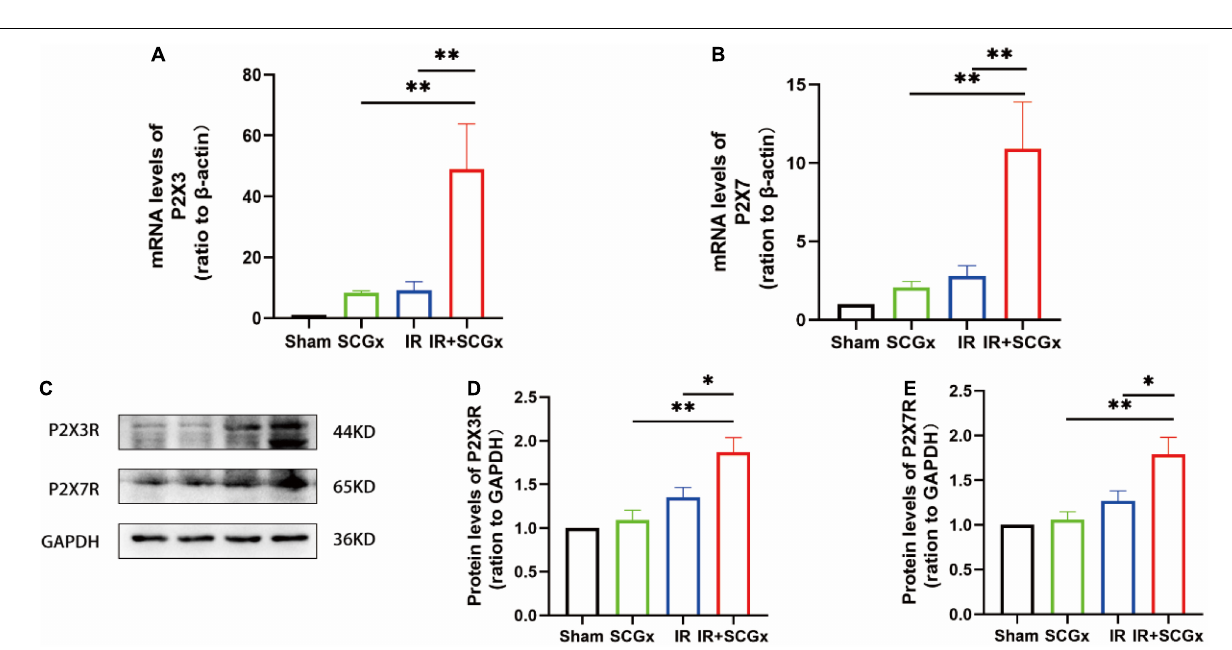
Frontiers in Medicine |